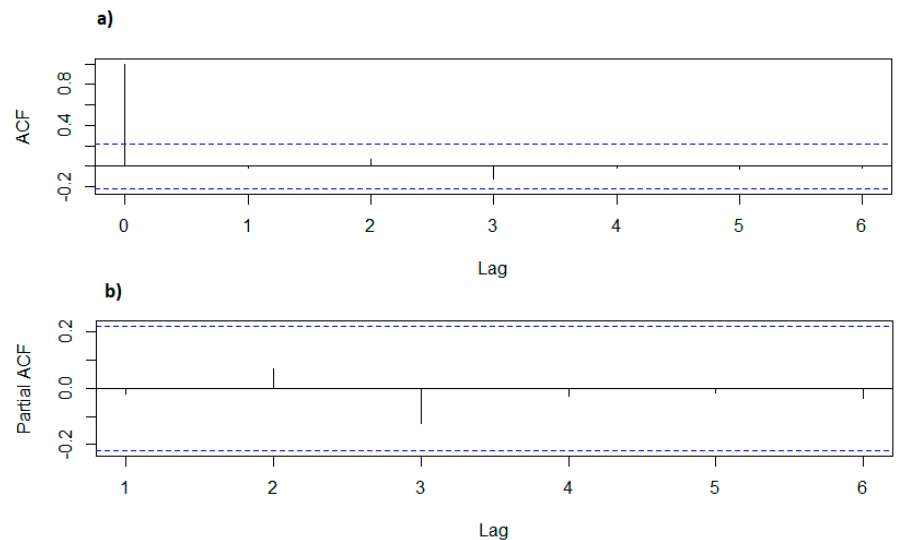
Figure 4. ( a ) Autocorrelation and ( b ) partial autocorrelation of residuals for the selected model.